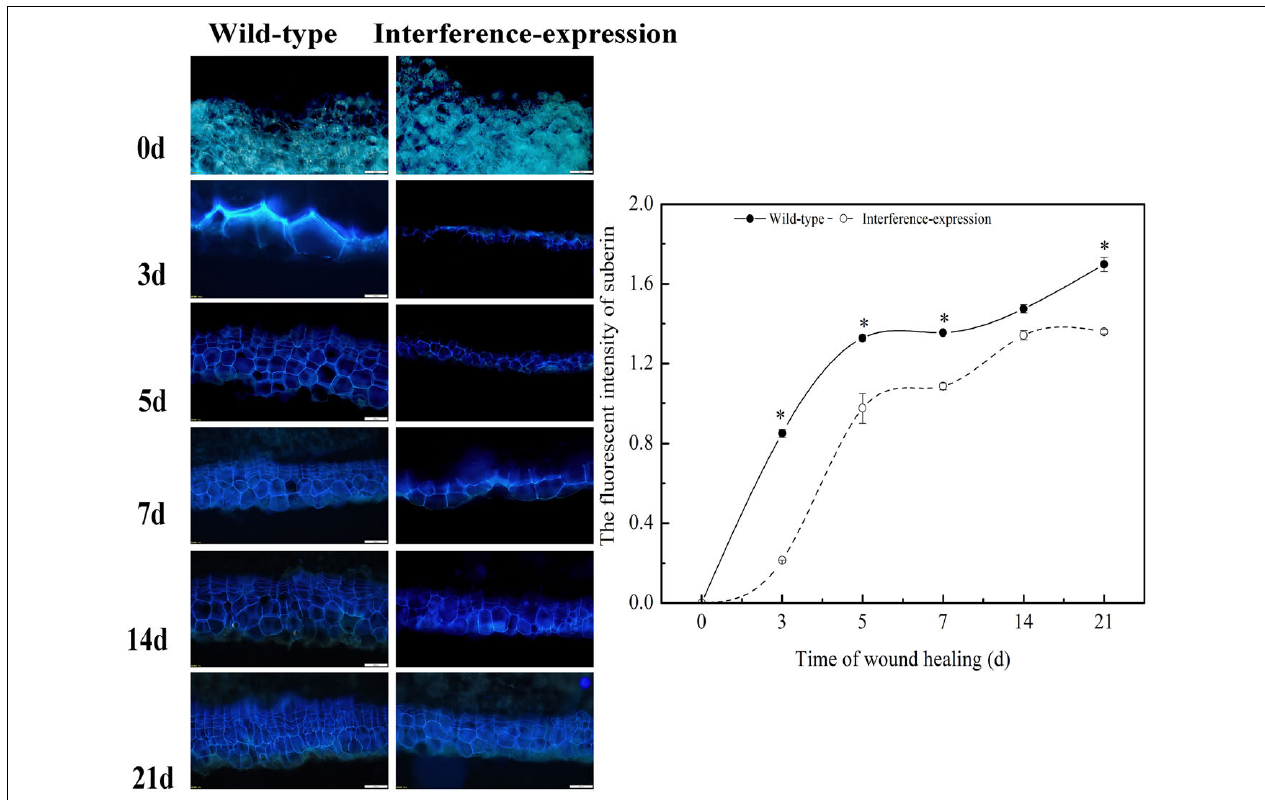
FIGURE 8 | Effect of StCDPK14 on suberin deposition at wound sites of tubers. Blue fluorescence indicated the suberin accumulation in wounded potato tubers. Bar = 200 µ m. The right chart is the fluorescent intensity of suberin of wild-type and interference-expression tubers (Data are presented as mean ± SD, n = 3, * P <